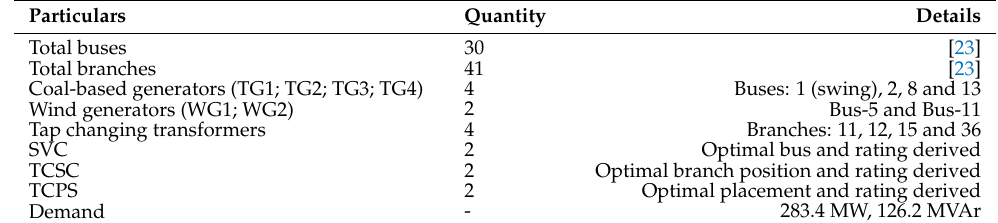
Table 1. Test system key features for analysis.